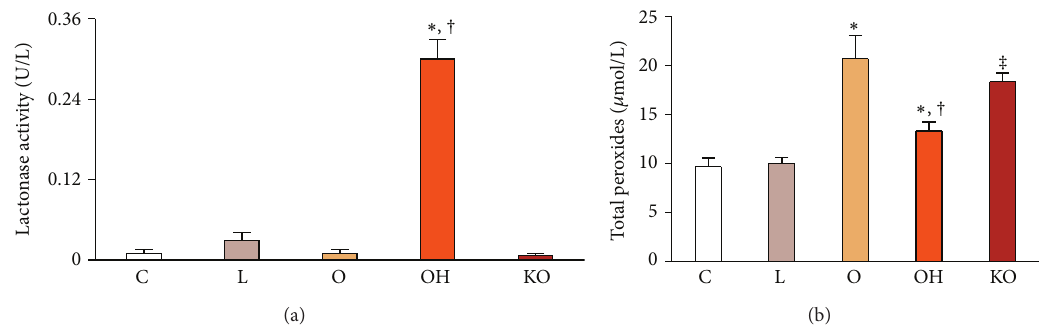
Figure 1: PON1 lactonase activity (a) and total peroxide concentrations (b) in the supernatant of the HUVEC cell culture ( 𝑛 = 3 , for each experiment). Endothelial cells were incubated over 24 h with 50 mg/L isolated human LDL (L); 50mg/L oxidized LDL (O); 50 mg/L oxidized LDL + 40mg/L HDL from wild type mice (OH); 50mg/L oxidized LDL + 40 mg/L HDL from PON1 (−/−) mice (KO); or with